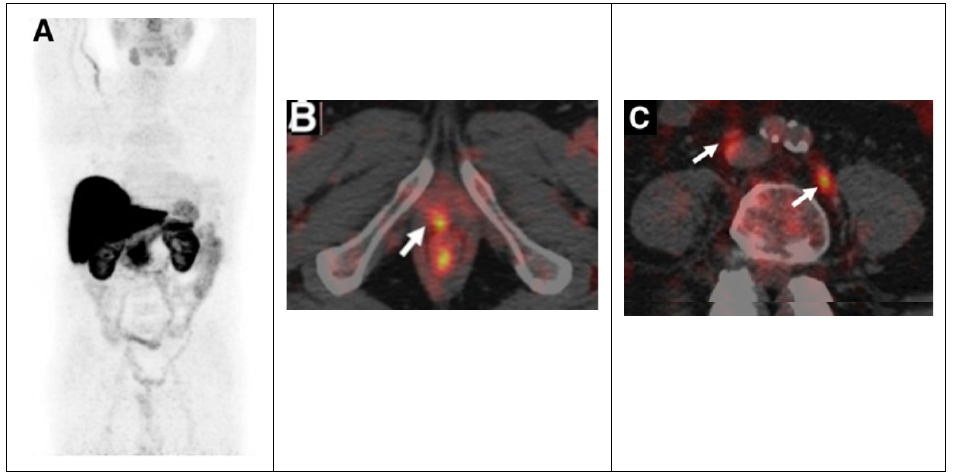
Figure 2. 64 CuCl 2 PET/CT in prostate cancer relapse. ( A ) 64 CuCl 2 biodistribution with high activity in the liver, and kidneys and lesser in the bowel. 64 CuCl 2 PET/CT image of pelvis from a old man treated with radical prostatectomy with rising PSA level demonstrated copper-avid recurrence in vescicourethral anastomosis ( B ) and nodes ( C ). Adapted from ref 21 with (This research was originally published in JNM. A. Piccardo et al. 64CuCl2 PET/CT in prostate cancer relapse. J. Nucl. Med. 2018 , 59 , 444–451. ©SNMMI.)